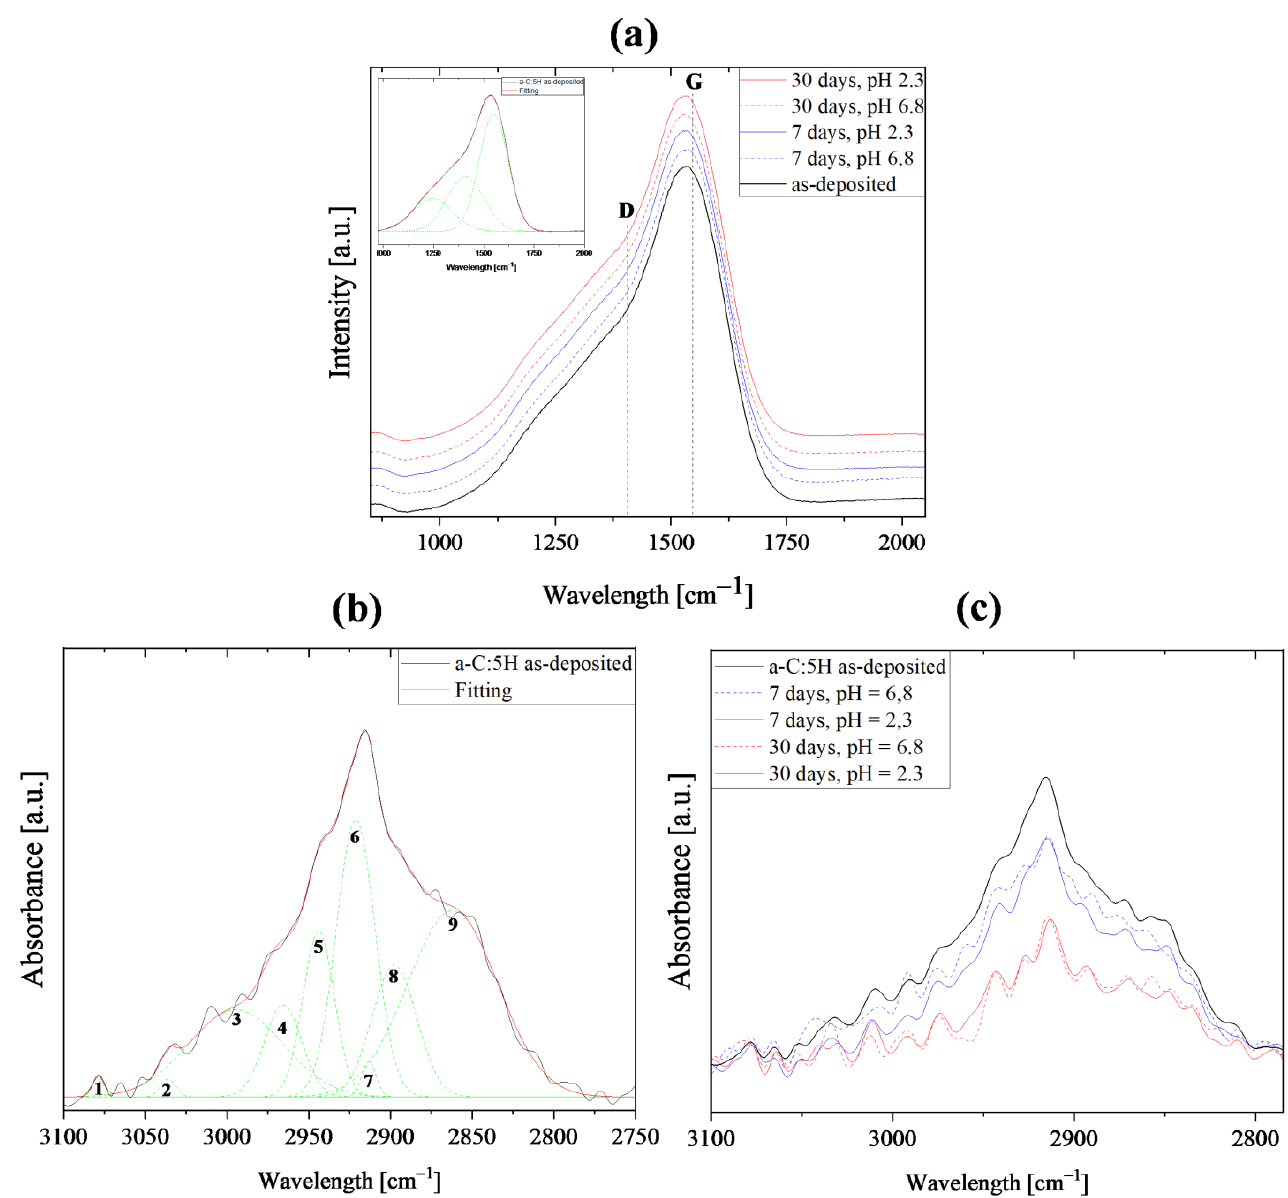
Figure 7. Structural characterization of the a-C:5H coatings before and after the corrosion tests by ( a ) visible Raman (inset: Gaussian fitting result of the as-deposited a-C:H coating); and ( b , c ) FTIR spectroscopy.